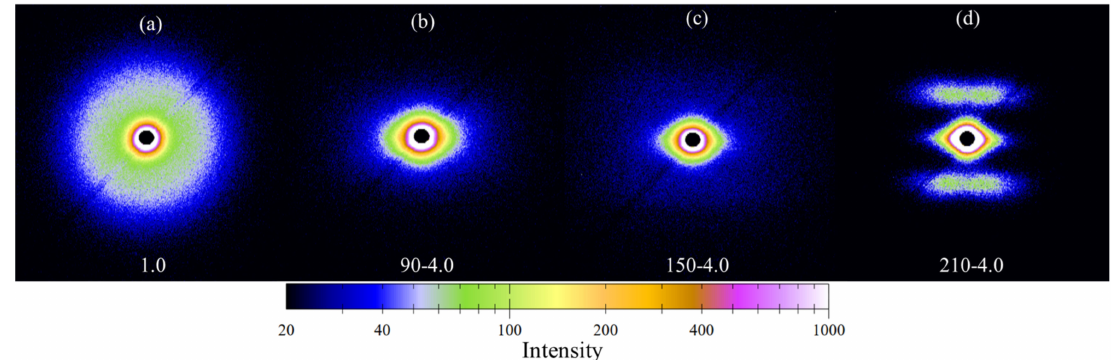
Figure 7. 2D-SAXS patterns of PA12T samples ( a ) unstretched, ( b – d ) stretching ratio is 4.0 and stretching temperatures are 90 ◦ C, 150 ◦ C and 210 ◦